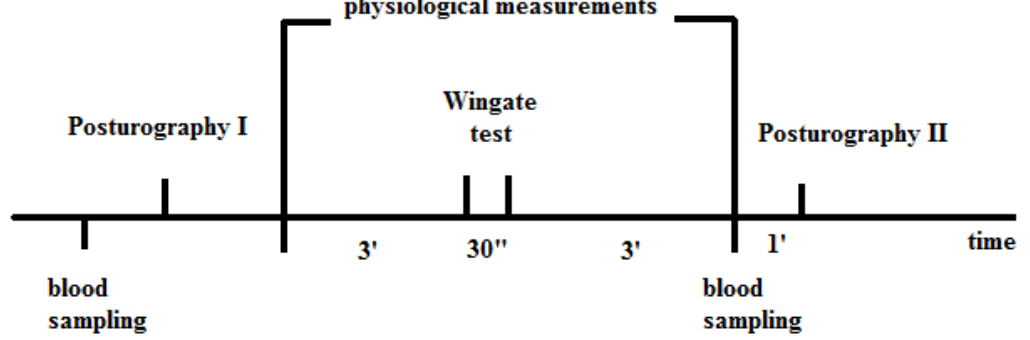
Figure 1. Scheme of visit in the laboratory.